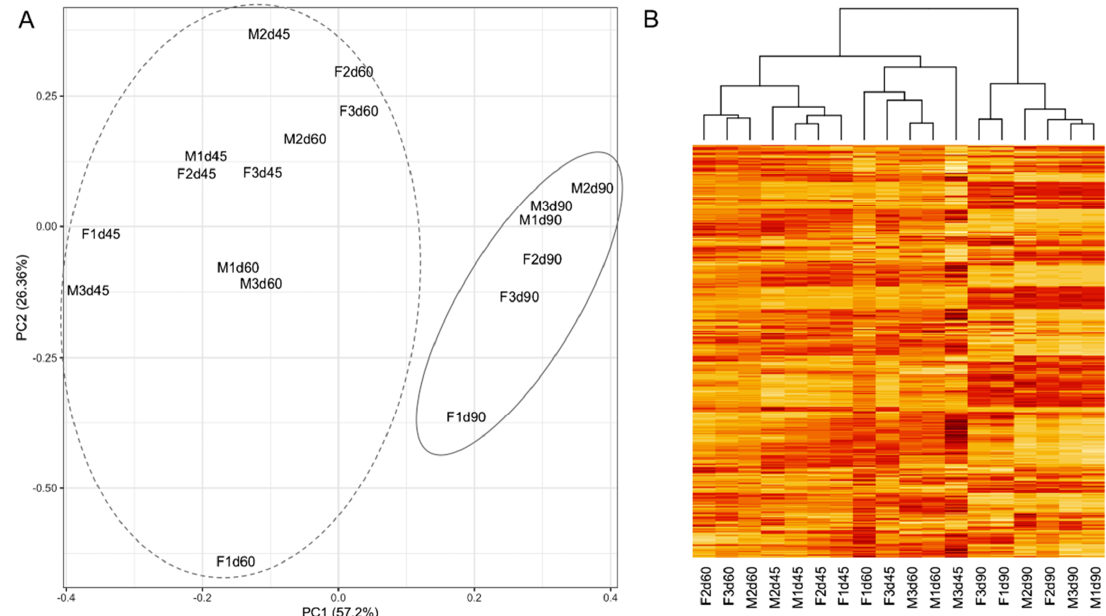
Figure 1. ( A ) Principal component analysis of gene expression variation of male (M) and female (F) fetal brains on GDs 45, 60 and 90. The dotted ellipse shows the group representing gene expression of fetal brain on GDs 45 and 60, and the solid ellipse shows the group representing gene expression of fetal brain on GD 90. ( B ) Heatmap of expression of genes in fetal brain samples also shows that GD 90 samples cluster differently than the samples of GDs 45 and 60.